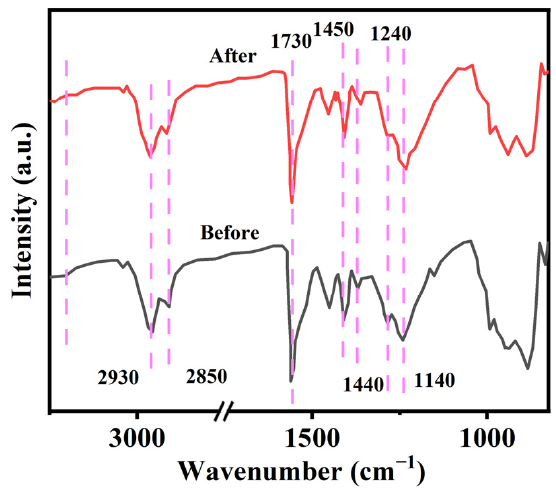
Figure 1. The FT-IR spectra of WAA coatings before and after modification by nano-SiO 2 .